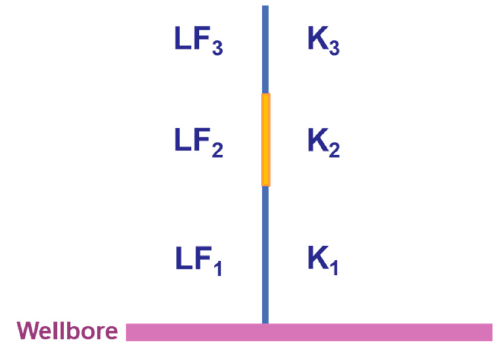
Figure 26. Effective model representing three fracture segments.